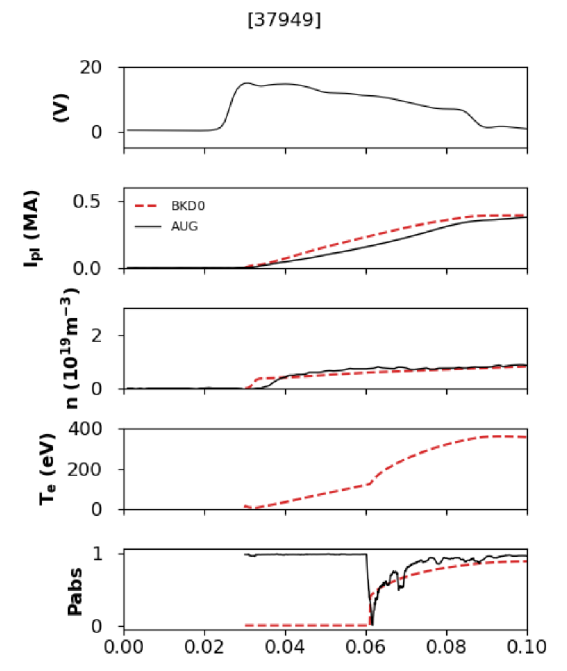
Figure 9. Comparison between BKD0 simulation (dashed red) and experimental time traces (black line) of #37949: Loop volt- age, plasma current, volume-averaged n e , T e and absorption. P EC : 0.7 MW, t EC , ON : 60 ms, neutral pressure: 4mPa, no im-